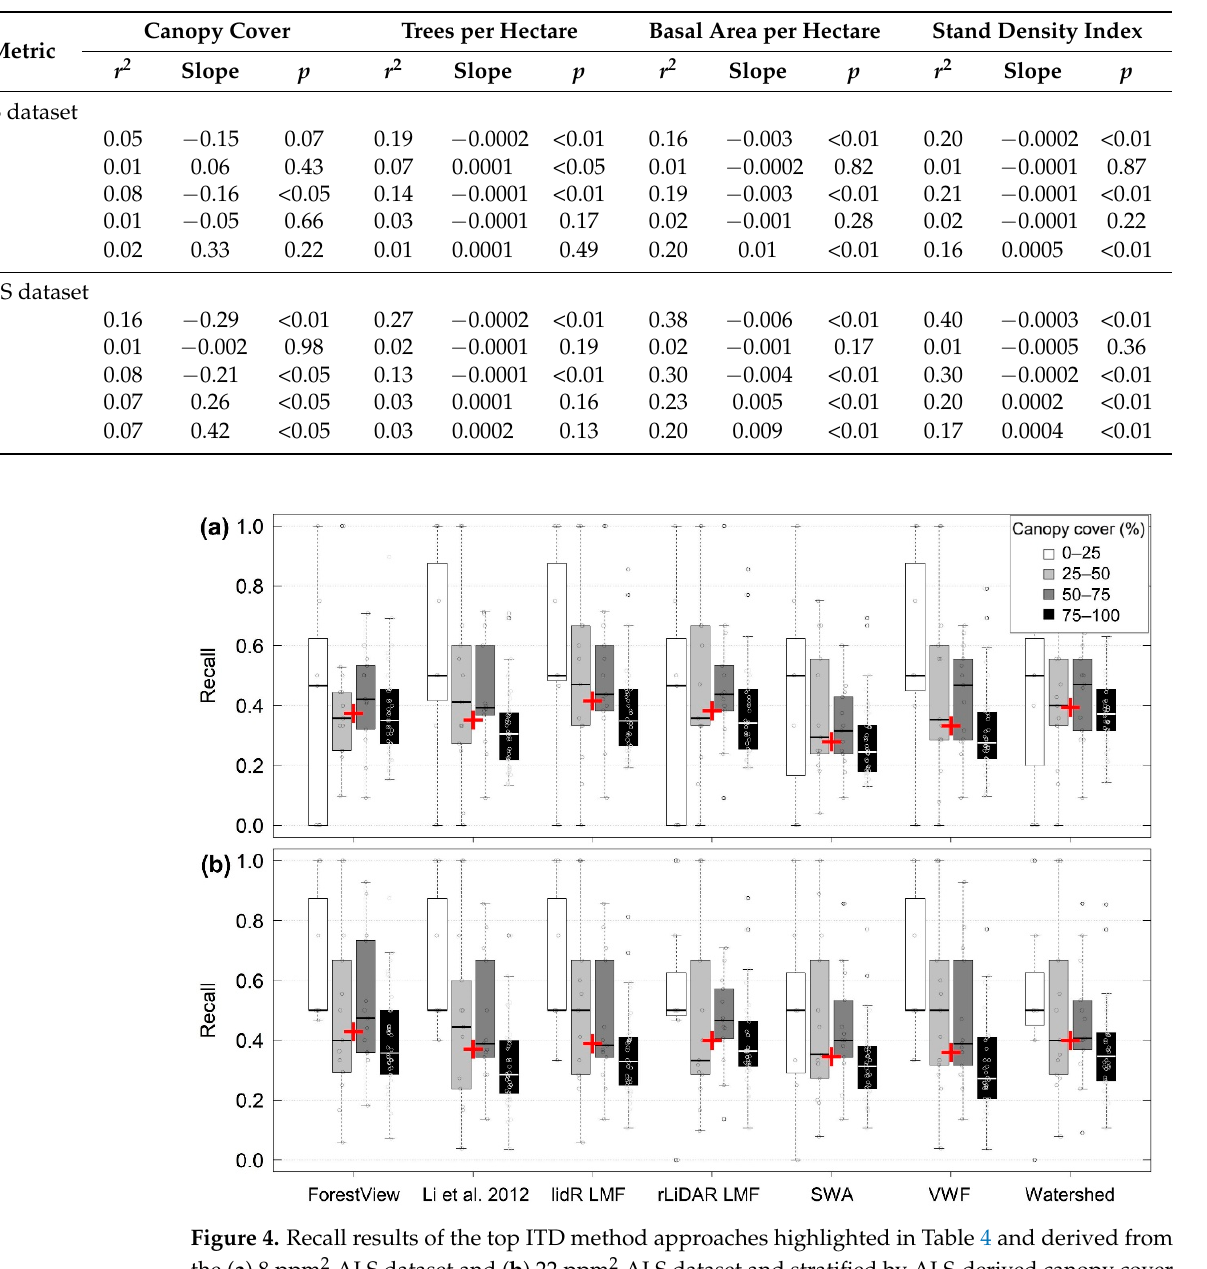
Table 5. Linear regression results between the top ITD method accuracies, averaged to the plot scale, and stand density metrics.